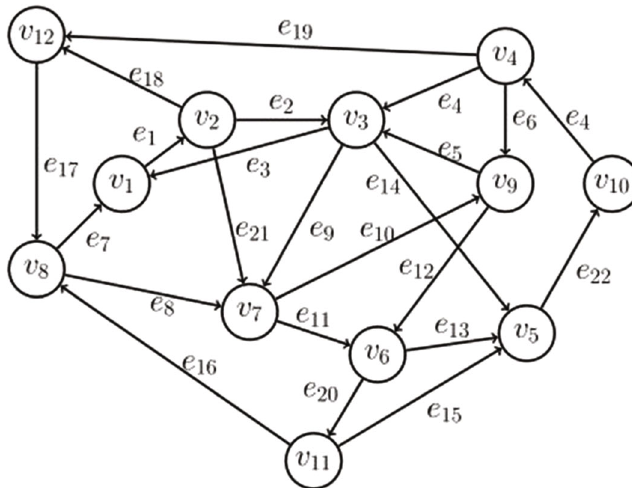
Figure 4: A directed graph with connection relationship. Table 1: One 8-simple directed path of directed graph in Figure 4. Path